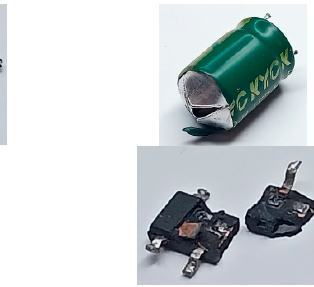
Figure 8. The results of the statistical analysis of damage of the integral parts of individual compo- nents of the type A lamp.